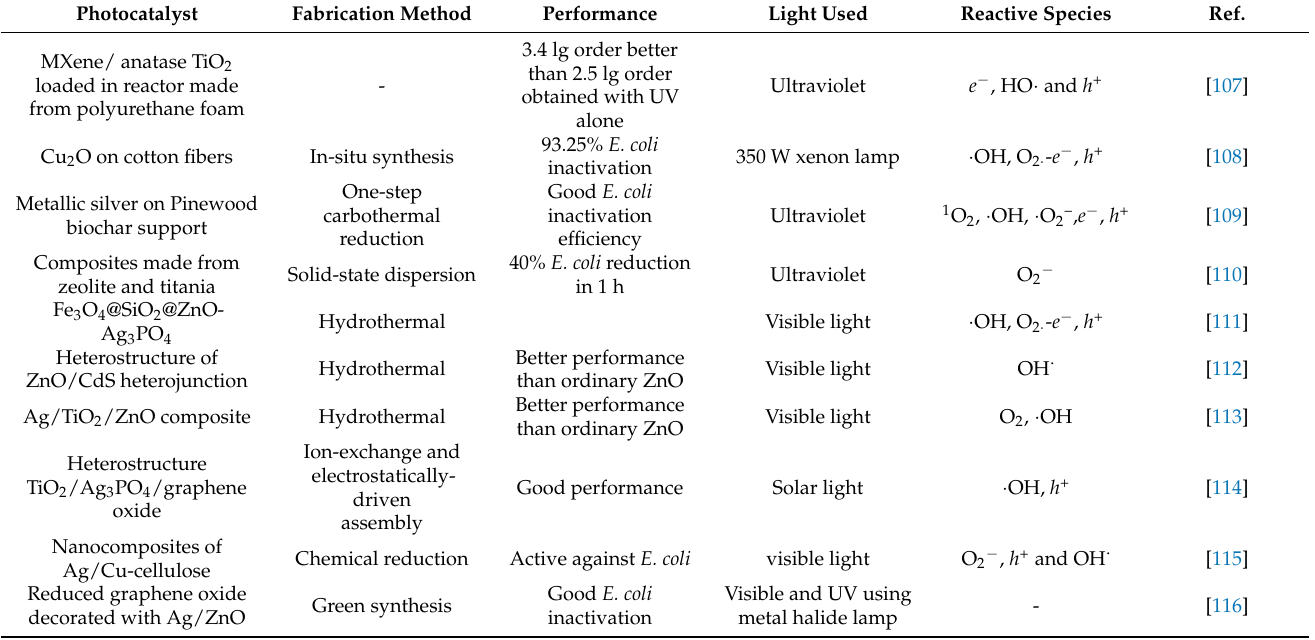
Table 1. Recent studies on the photocatalytic inactivation of E.